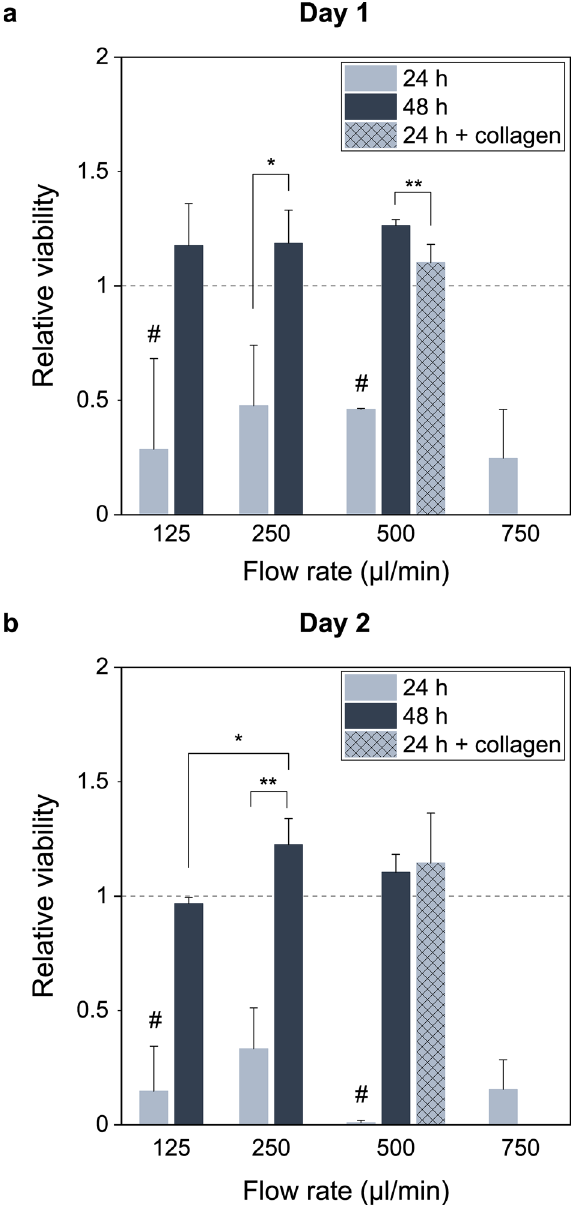
Figure 2. The relative viability of A549 cells cultured under flow, normalized to statically grown cells (controls of each experiment). The cells were let to attach for 24 or 48 h onto a non-coated coverslip or a collagen-coated coverslip. The graphs present the cell viabilities assessed with AlamarBlue assay after 1 ( a ) and 2 ( b ) days of culture inside the QuasiVivo system (mean ± s.d., each n includes the mean viability of two chambers from the same system). # n = 2; *p < 0.05; **p <